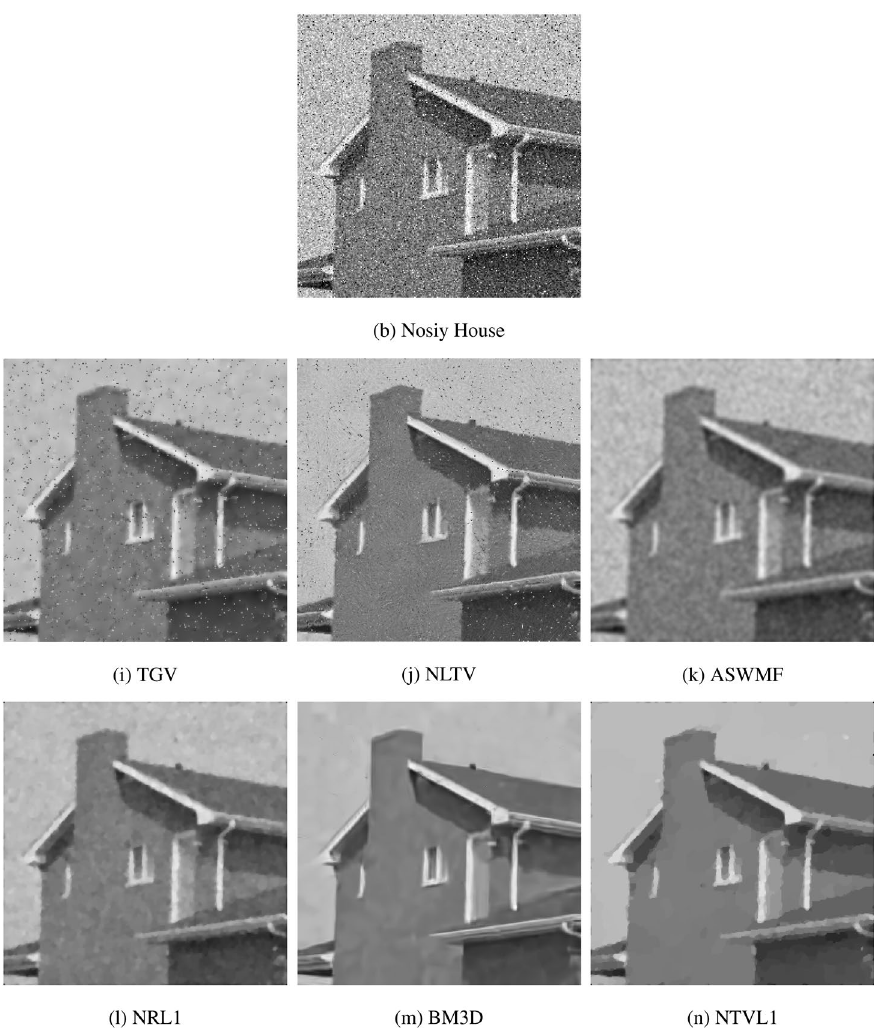
Figure 12. The comparison with TGV, NLTV, NRL1, ASWMF and BM3D.